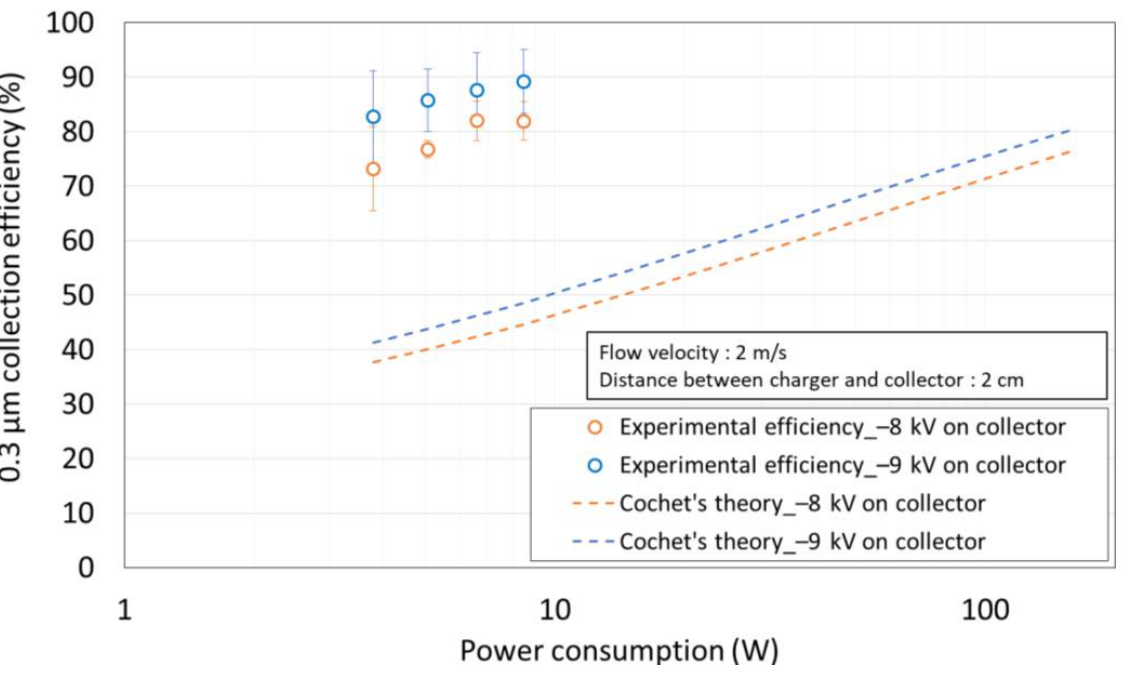
Figure 5. Comparison of the experimental efficiency and Cochet’s theoretical efficiency according to the power consumption.